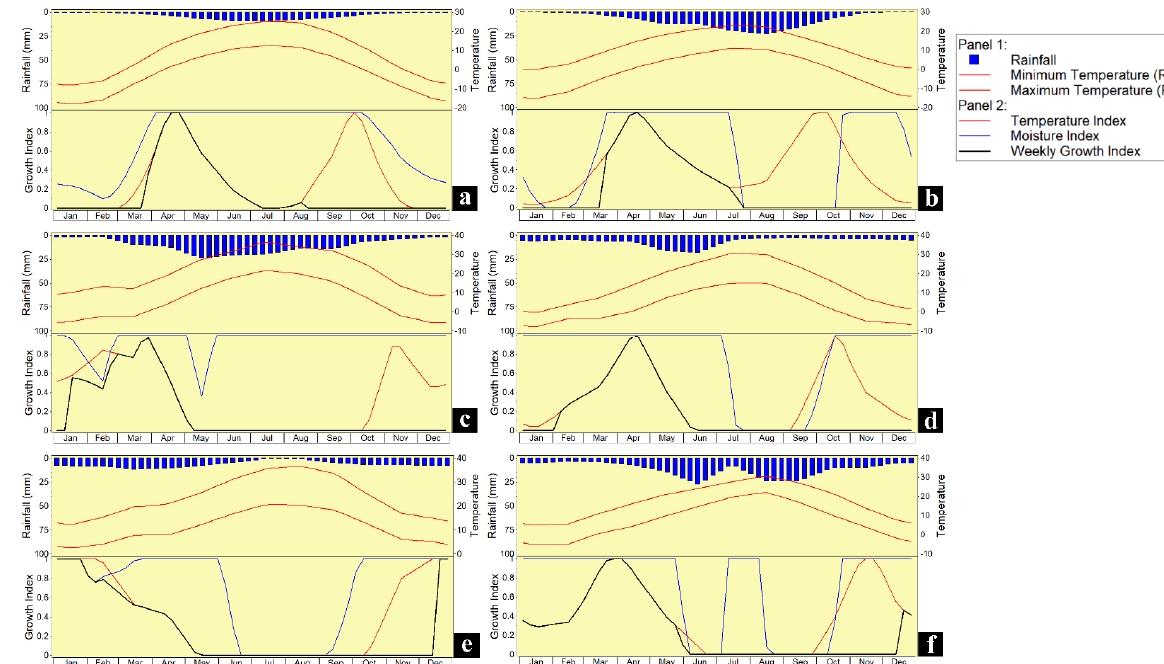
Figure 8. Predicted growth index of Apocheima cinerarius: ( a ) Hutubi; ( b ) Linxia; ( c ) Nebraska; ( d ) Alberta; ( e ) Castilla; ( f ) Nanjing Road.